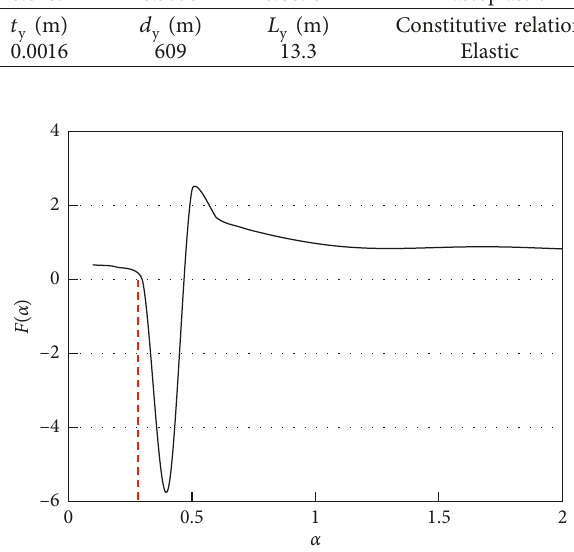
Figure 8: Relation curve of F